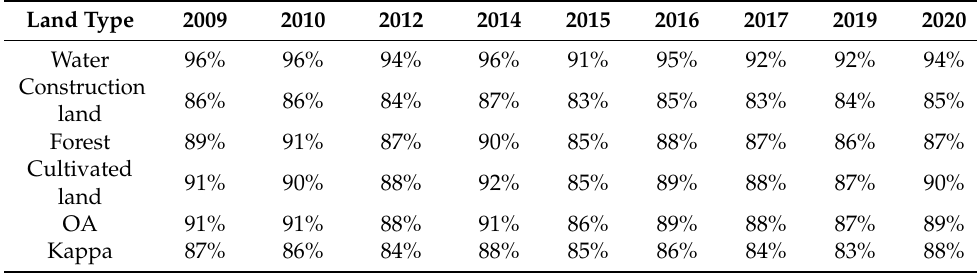
Table 3. Precision of the land-use classification